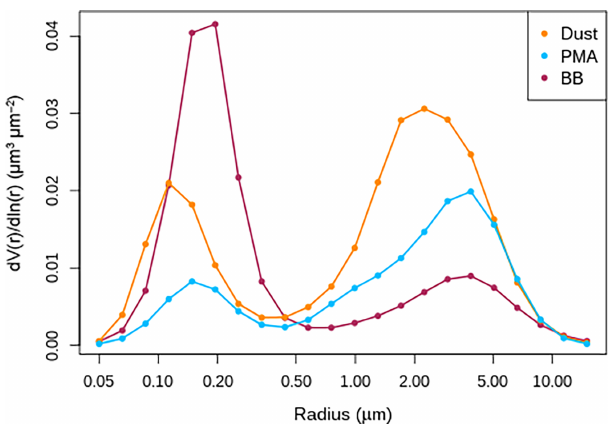
Figure 13. AERONET volume size distributions averaged for the three